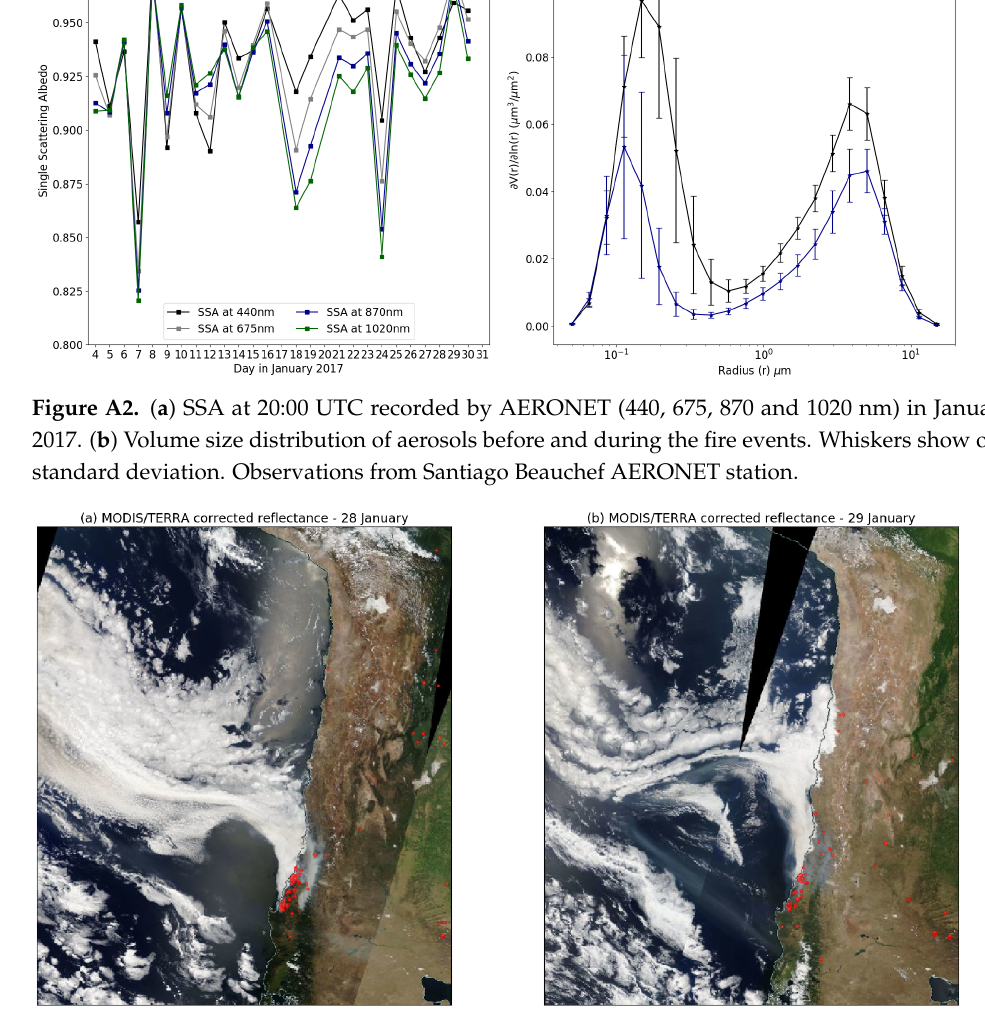
Figure A3. ( a ) Same as Figure 7a for 28 January. ( b ) Same as ( a ) for 29